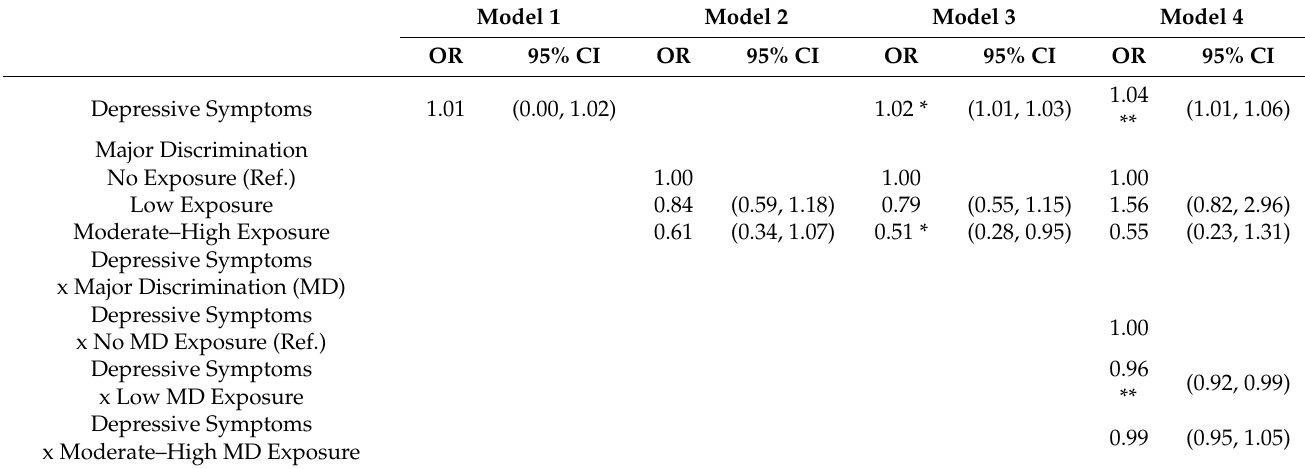
Table 4. Chronic Conditions Regressed on Depressive Symptoms and Lifetime Major Discrimination among Black Women, Nashville Stress and Health Study